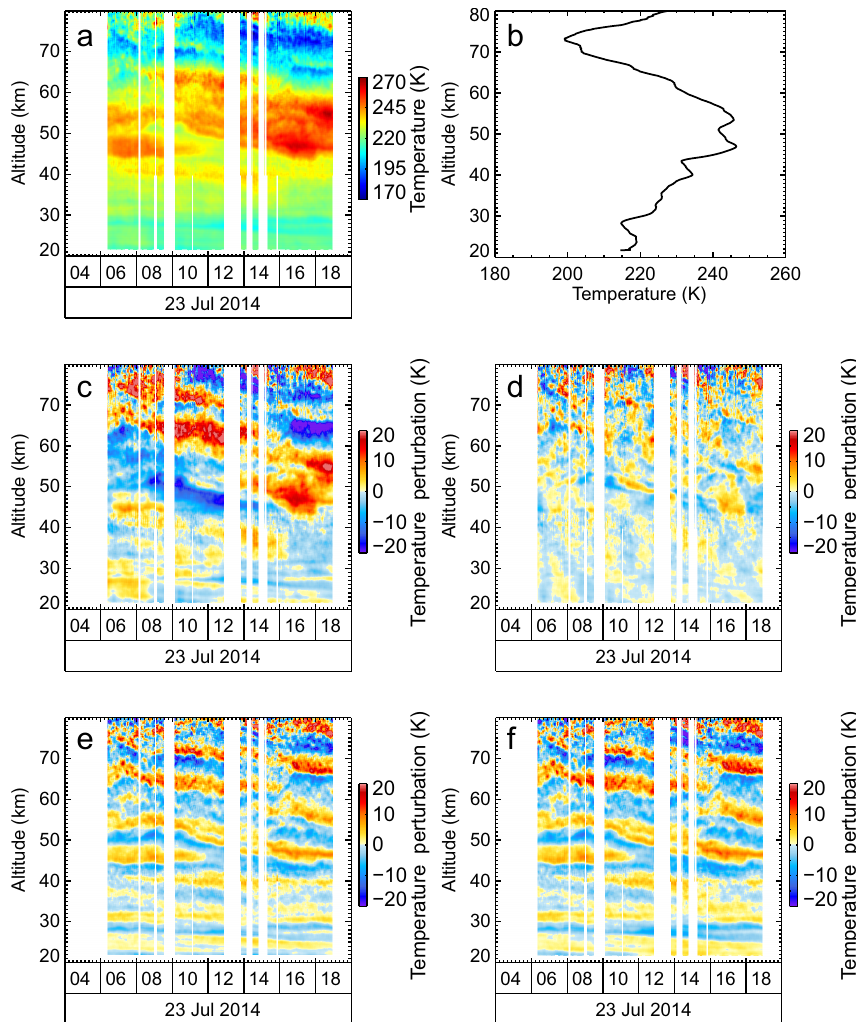
Figure 6. Temperature (a) , mean temperature profile (b) and derived temperature perturbations obtained by different methods (c–f) over Lauder, New Zealand, (45.0 ◦ S, 169.7 ◦ E) on 23 July 2014. The following methods were used for the different panels: nightly mean (c) , 3h running mean (d) , sliding polynomial fit (e) , and Butterworth filter (f) . Time is given in